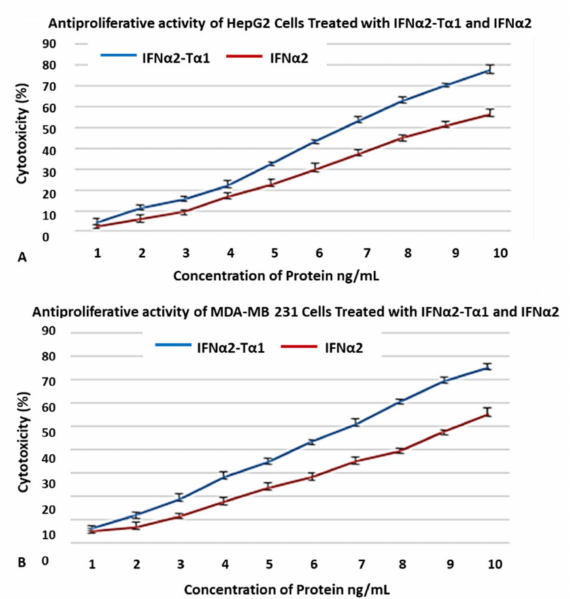
Figure 3. Anti-proliferative effect of IFN α 2–T α 1 or IFN α 2 alone in HepG2 and MDA-MB-231 cells measured by MTT assay. ( A ) HepG2 cells and ( B ) MDA-MB-231 cells treated with various concentrations of IFN α 2–T α 1 or IFN α 2 for 24 h and analysis of cell growth inhibition by MTT assay. Data are represented as Mean ± SD (n = 3, two-way ANOVA, p < 0.05 considered significant with 95%